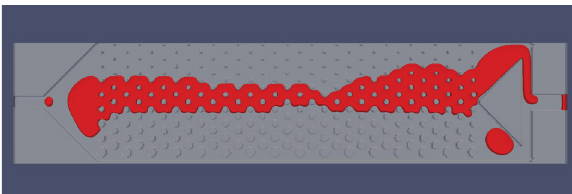
Fig. 4 – Simulation snapshot of the initial geometry. Inlet is on the left-hand side while outlet is on the right-hand side of the picture. The wetting phase is transparent, while the non-wet- ting phase is pictured red. Flow ratio wetting : non-wetting = 2:1; Re=0.14;